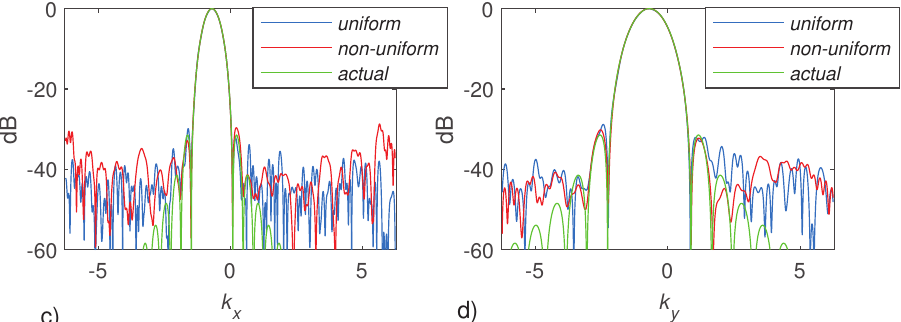
Figure 5. Normalized amplitude of the radiation pattern of J 1 ( x , y ) with X s = 8 λ , Y s = 4 λ , z o = 7 λ , X 0 = 30 λ and Y 0 = 15 λ . In ( a ), the radiation pattern is obtained by employing the near-field data according to the proposed non-uniform sampling scheme over the grid shown in ( b ) of Figure 2 and then interpolated over a λ /2 grid. In (b), the radiation pattern is obtained by directly employing the near-field data over a uniform λ /2 grid. Panels ( c , d ) have been obtained by fixing k y = k sin ( π /20 ) sin ( π /4 ) and k x = k sin ( π /20 ) cos ( π /4 ) , respectively, and compare the radiation pattern cut-views passing through the main-beam maximum. The green lines refer to the actual radiation pattern, the blue lines to the radiation pattern computed by using the uniform λ /2 sampling and the red ones show the radiation pattern obtained by the proposed method. Noisy case with additive complex white Gaussian noise and SNR = 20 dB.